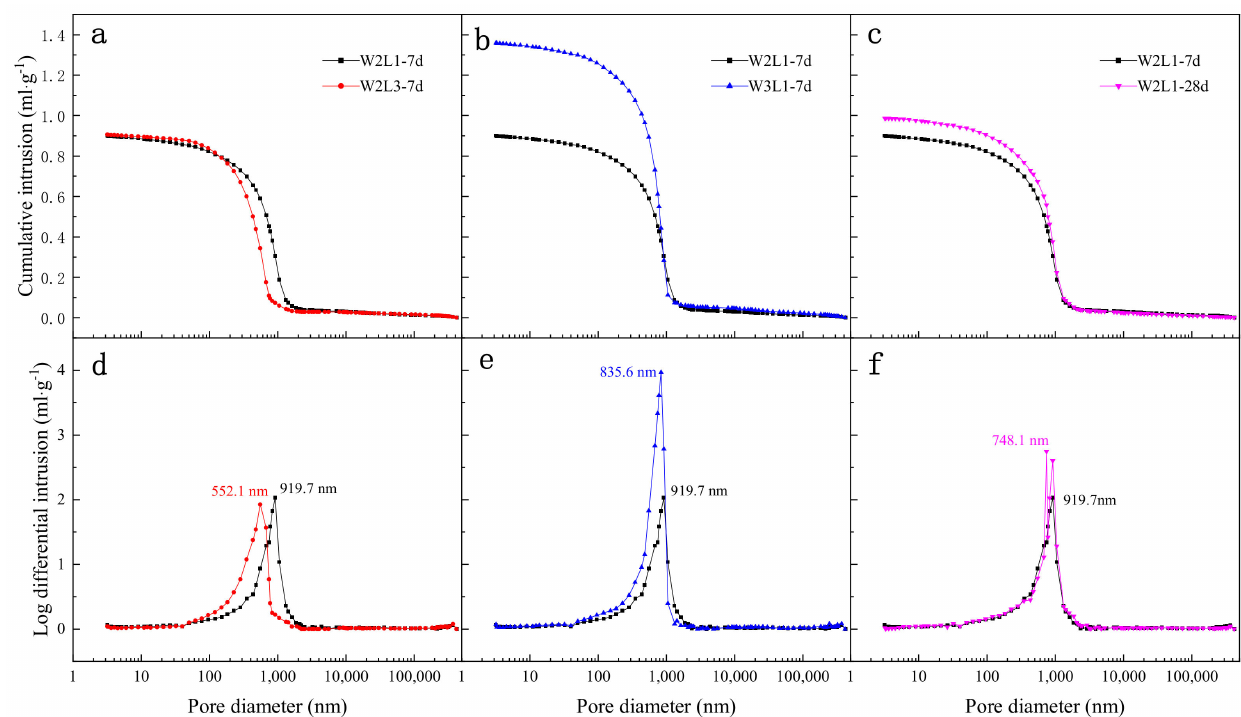
Figure 3. The pore size distribution of samples with different mixtures in cumulative ( a – c ) and differential ( d – f ) forms.